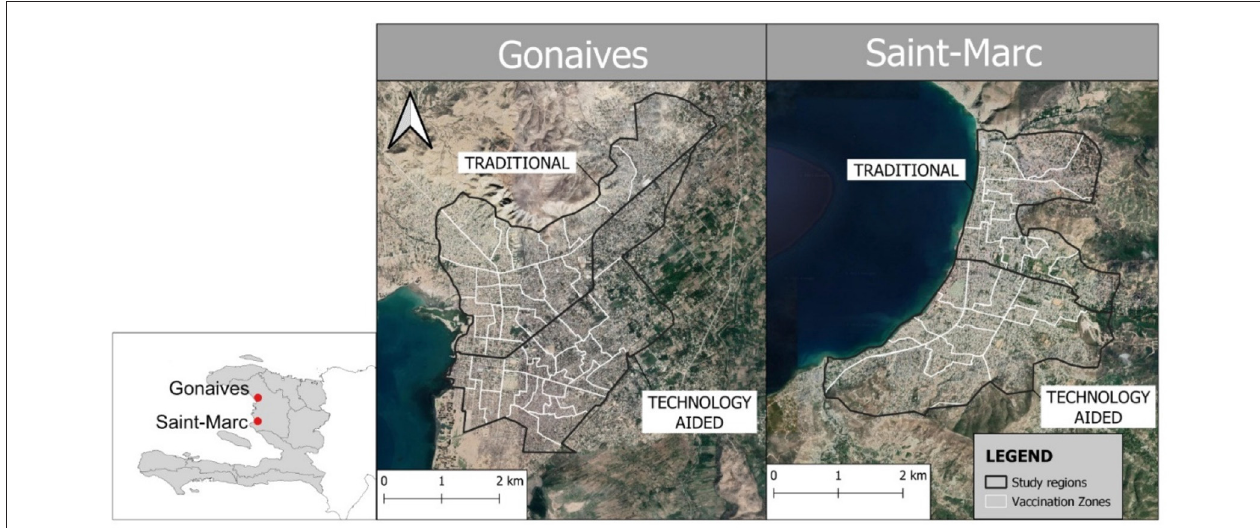
FIGURE 1 | Map showing Gonaives and Saint-Marc study regions (black) and vaccination zones (white). Base map is Google Satellite © . Insert shows the location of the two cities in Haiti.